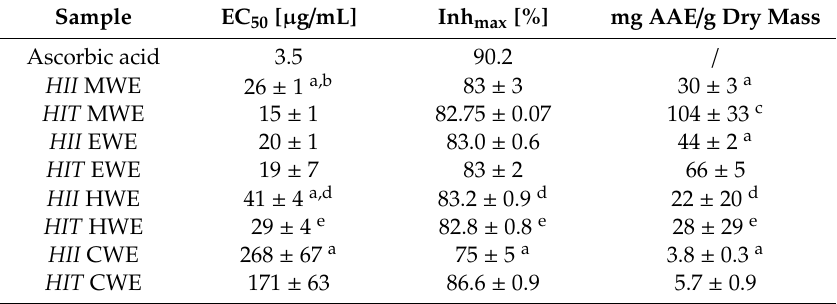
Table 2. Antioxidant potential of H. italicum samples determined by DPPH test and expressed as EC 50 and ascorbic acid equivalents (AAE).